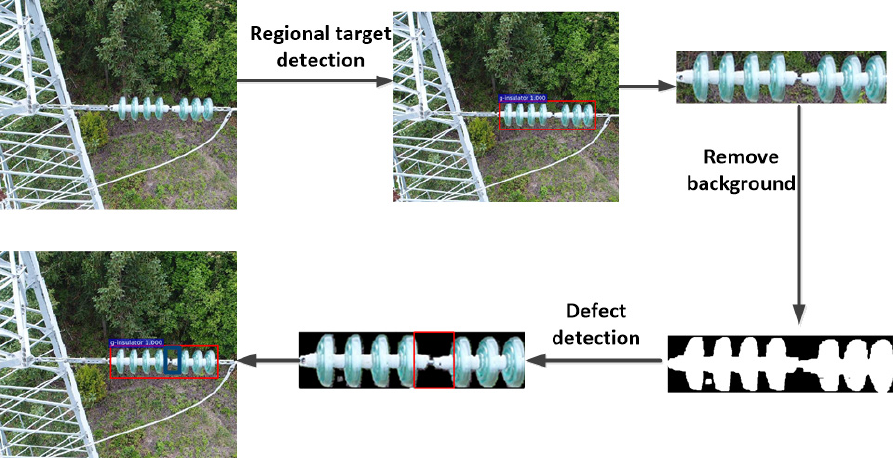
Figure 1. Insulator defect detection process.